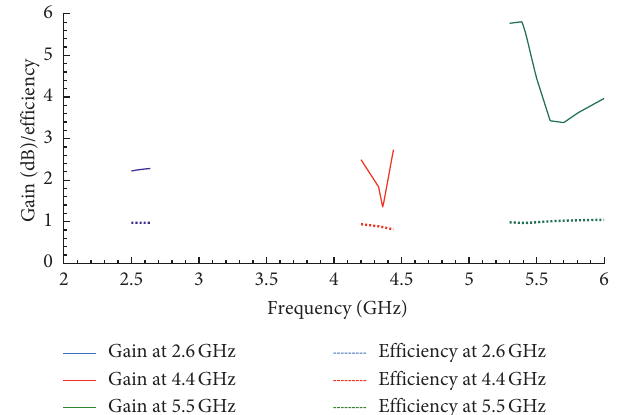
Figure 9: Gain and efficiency of the Deliciosa BioAs-MPA antenna.